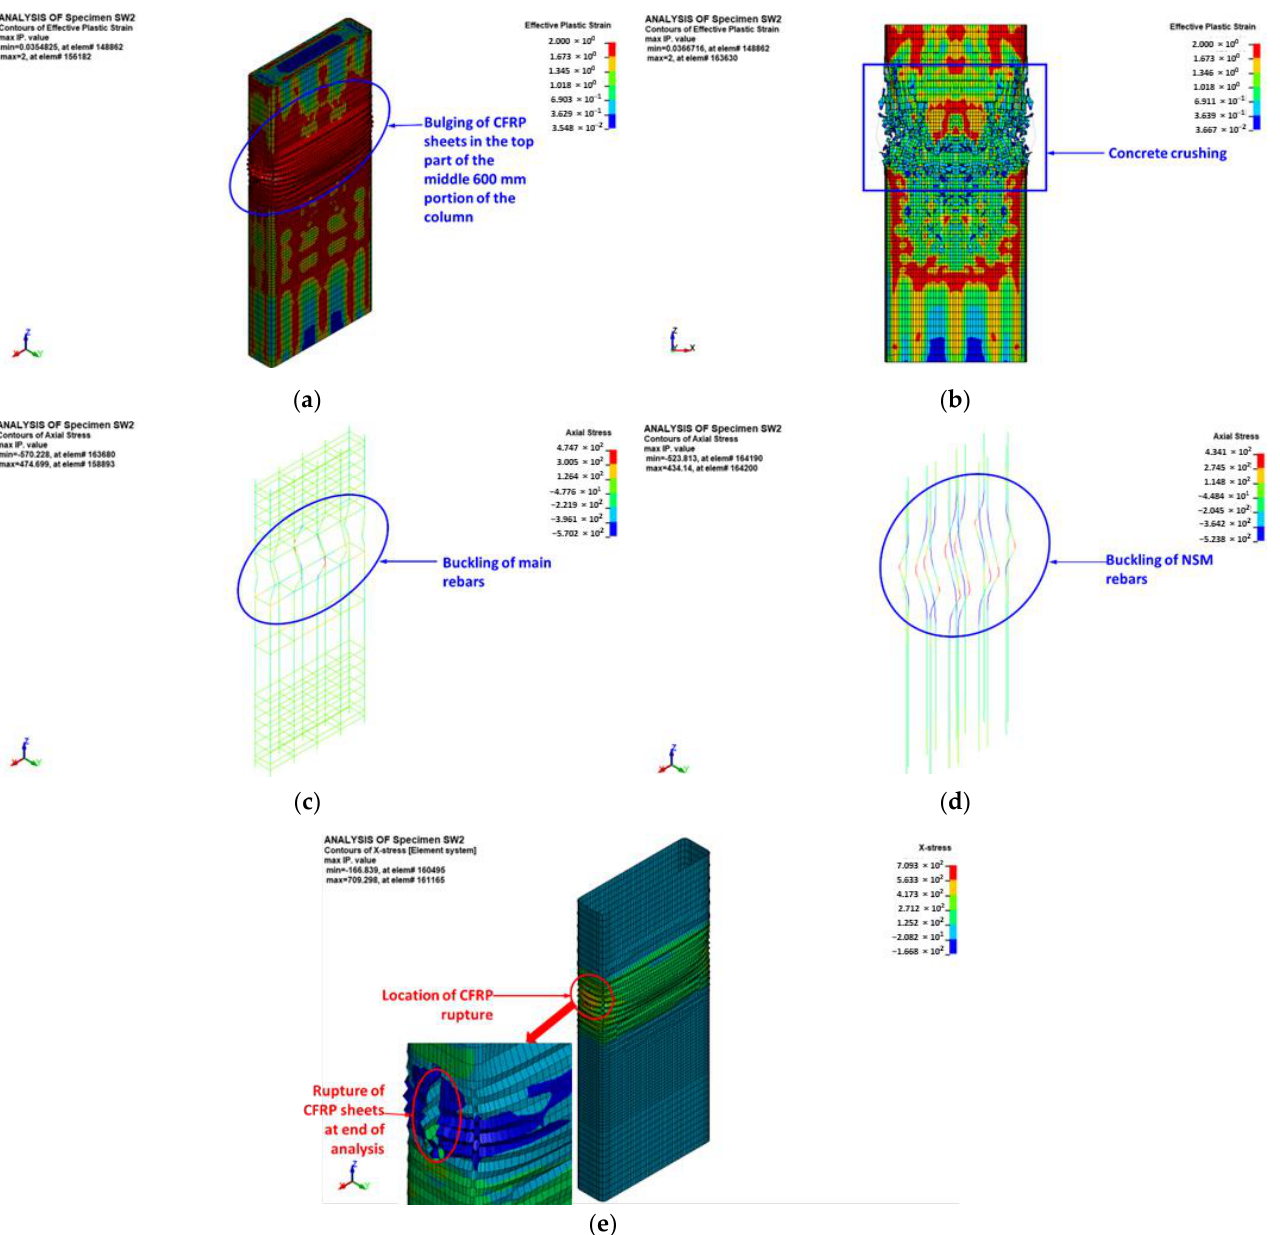
Figure 23. FE mode of failure for strengthened specimen SW2: ( a ) bulging of CFRP sheets at peak load; ( b ) effective plastic stress contours for concrete elements; ( c ) axial stress contours for main rebar elements; ( d ) axial stress contours for NSM rebar elements; and ( e ) X-stress contours for shell elements of CFRP sheets.